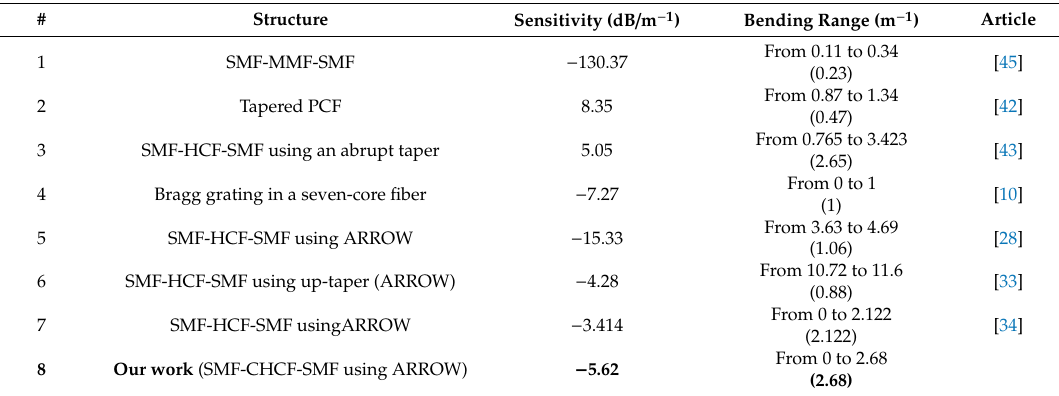
Table 1. Comparison of the parameters of our sensor with the reviewed